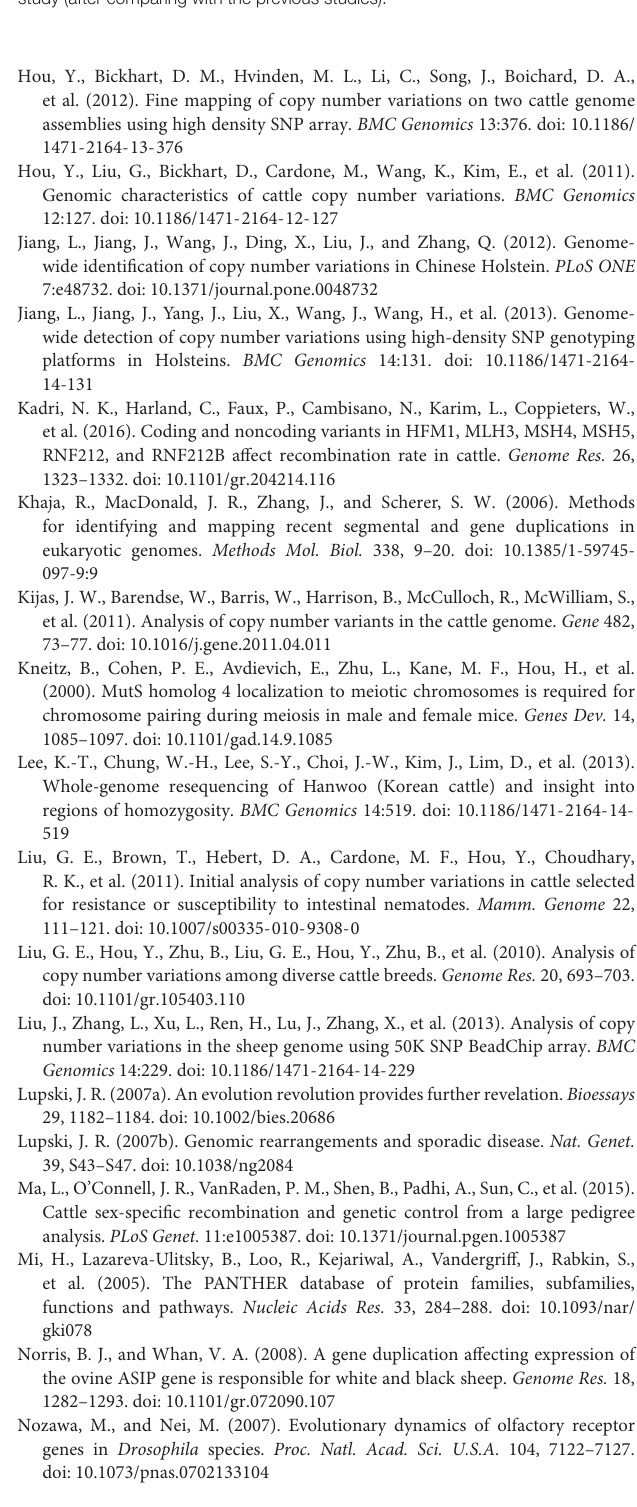
TABLE S8 | Information about Ensembl genes found to be overlapped with CNVR identified in the present study. TABLE S9 | Information about Ensembl genes found to be overlapped with unique CNVR that are only identified in the present study.